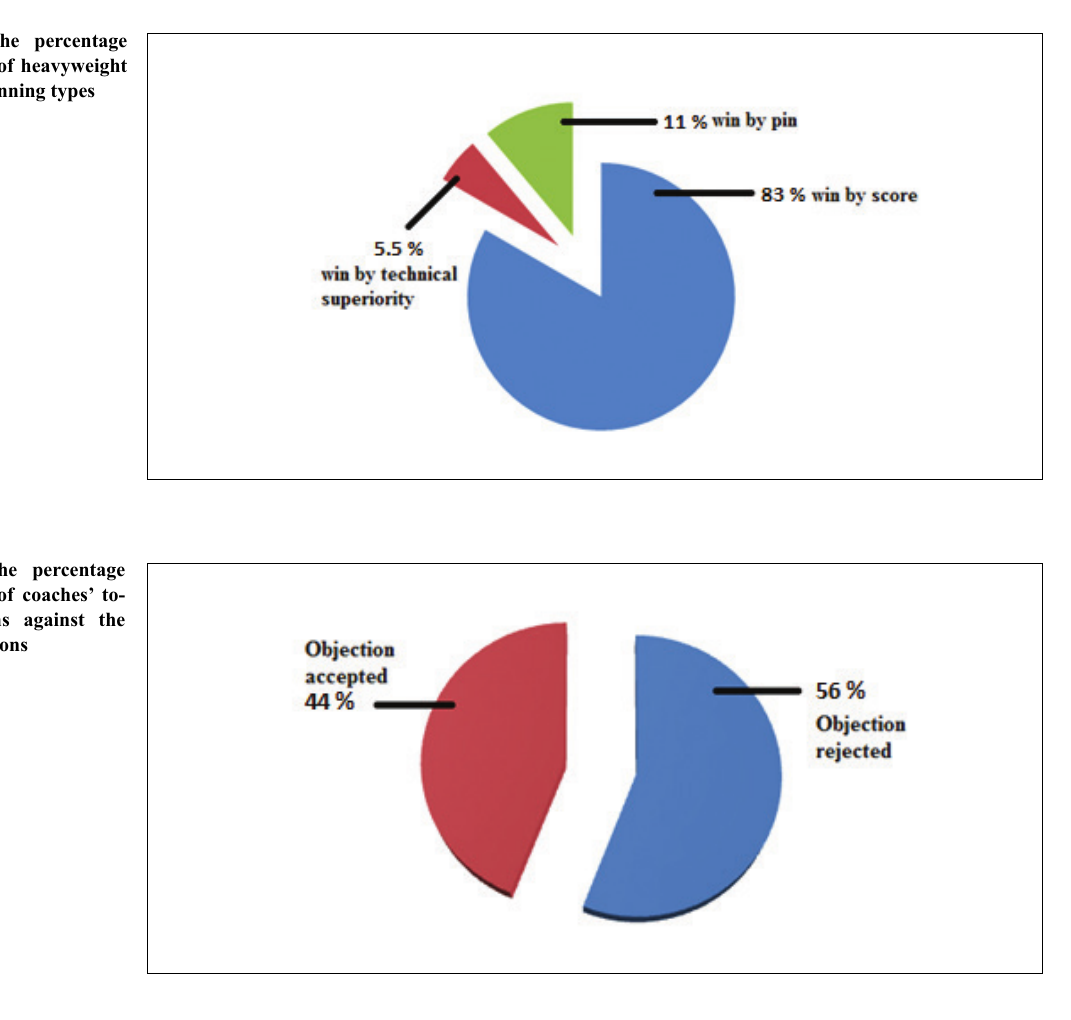
Figure 6. The percentage distribution of heavyweight wrestlers’ winning types